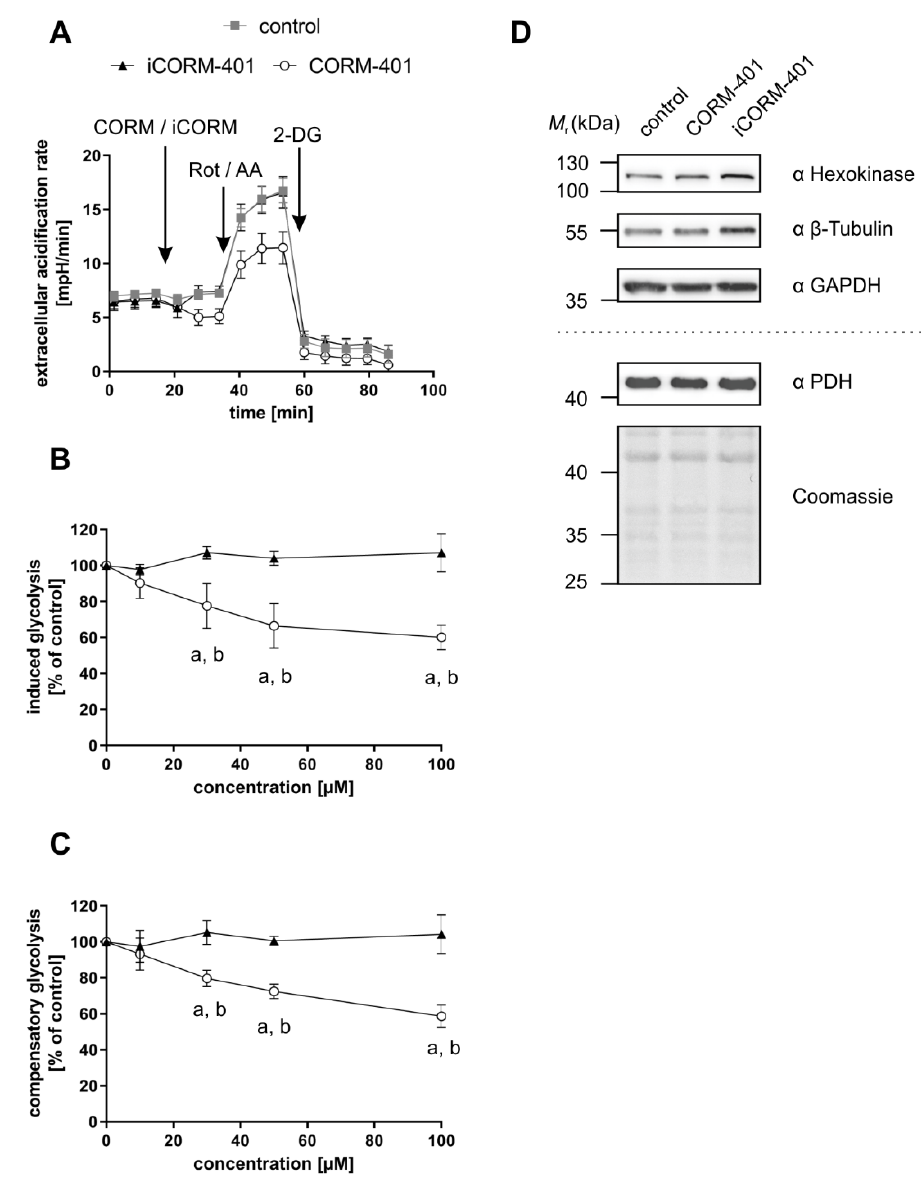
Figure 4. CO-dependent decrease of glycolytic parameters is independent of glycolysis enzyme protein levels. CORM-401 and iCORM-401 were injected into reaction wells and the glycolytic rate assay (sequential injection of rotenone + antimycin A and 2-DG) was performed. Injections are indicated by arrows. Representative ECAR curves are given ( A ) with a final concentration of CORM-401 / iCORM-401: 50 µ M. Data represent mean ± SD of at least six technical replicates. Quantifications of the glycolytic parameters compensatory glycolysis ( B ) and induced glycolysis ( C ) are shown for 10–100 µ M CORM-401 / iCORM-401. Data represent mean ± SD of three independent experiments (n = 3). Representative Western blot analyses of glycolysis enzymes after treatment of MEFs with 50 µ M CORM-401 / iCORM-401 or medium only for 30 min are shown ( D ). The dashed line separates results of two di ff erent gels, loaded with the same samples (n = 3). ECAR = extracellular acidification rate, Rot / AA = rotenone + antimycin A, 2-DG = 2-deoxyglucose, PDH = pyruvate dehydrogenase. Statistical analysis was performed using one-way ANOVA and detailed results are given in Table S3.